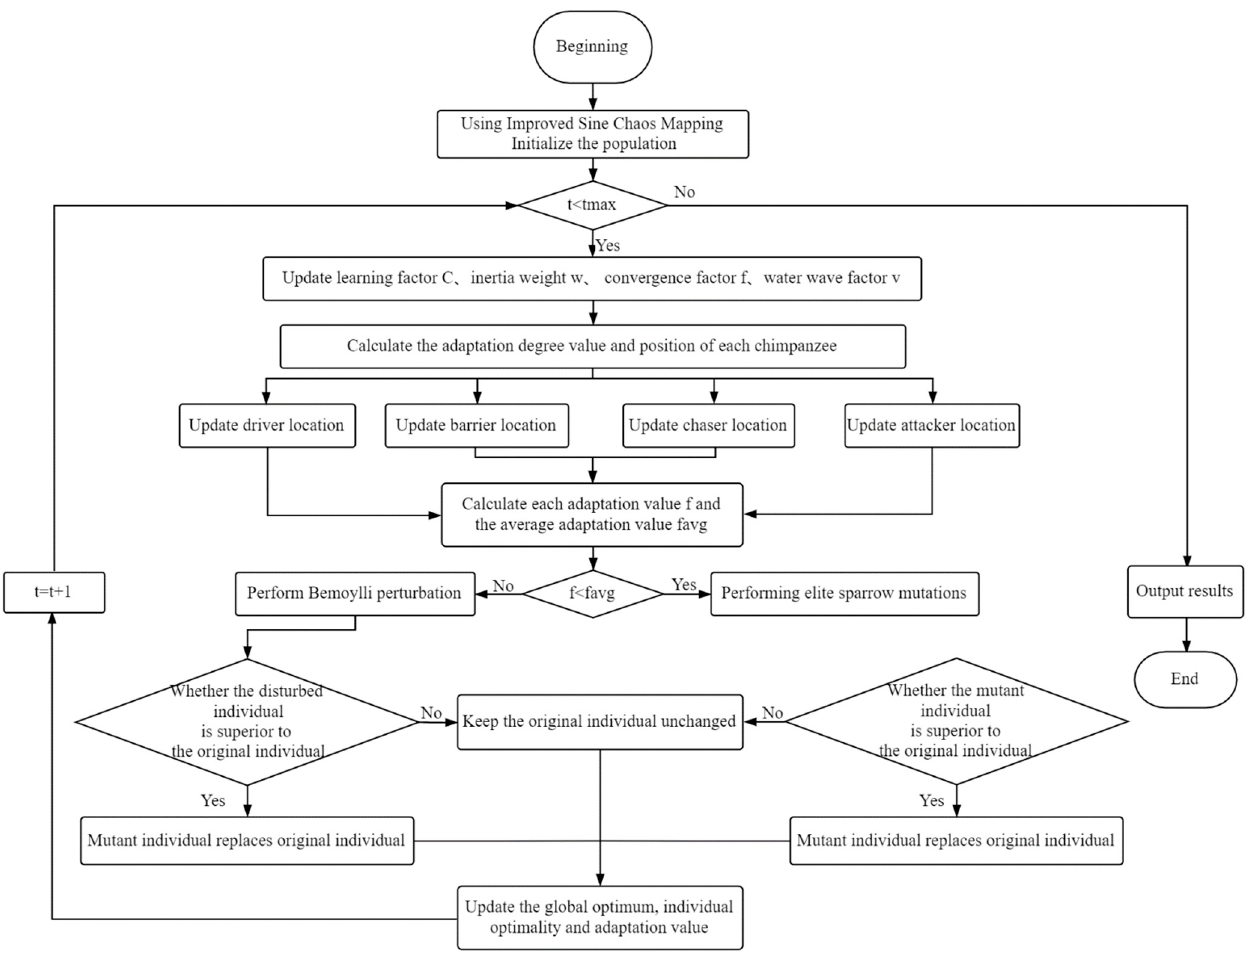
Figure 6. Flow chart of IMSChoA algorithm Figure 6. F low chart of IMSChoA algorithm optimization.